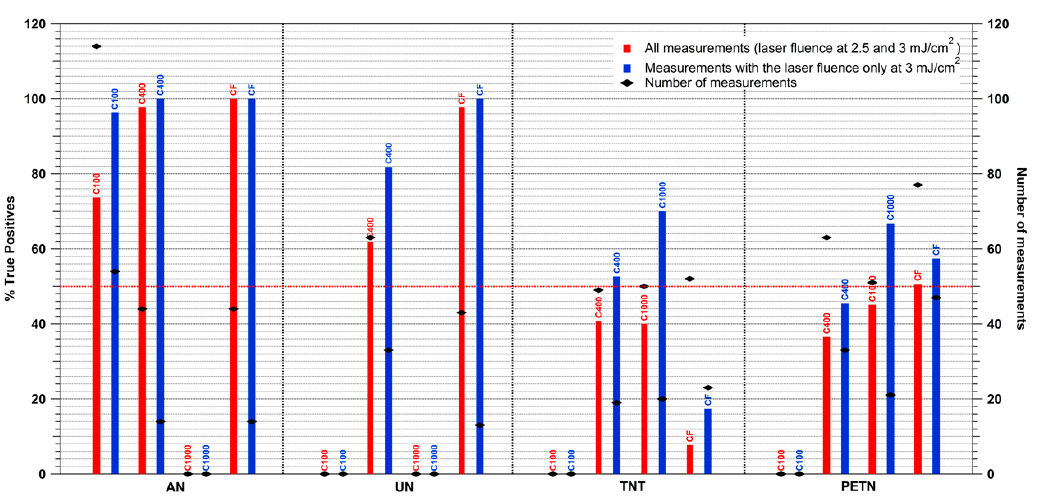
Figure 11. Percentages of true positives for AN, UN, TNT and PETN from al measurements with laser fluence at 2.5–3 mJ/cm 2 and for all measurements with laser fluence at only 3 mJ/cm 2 .